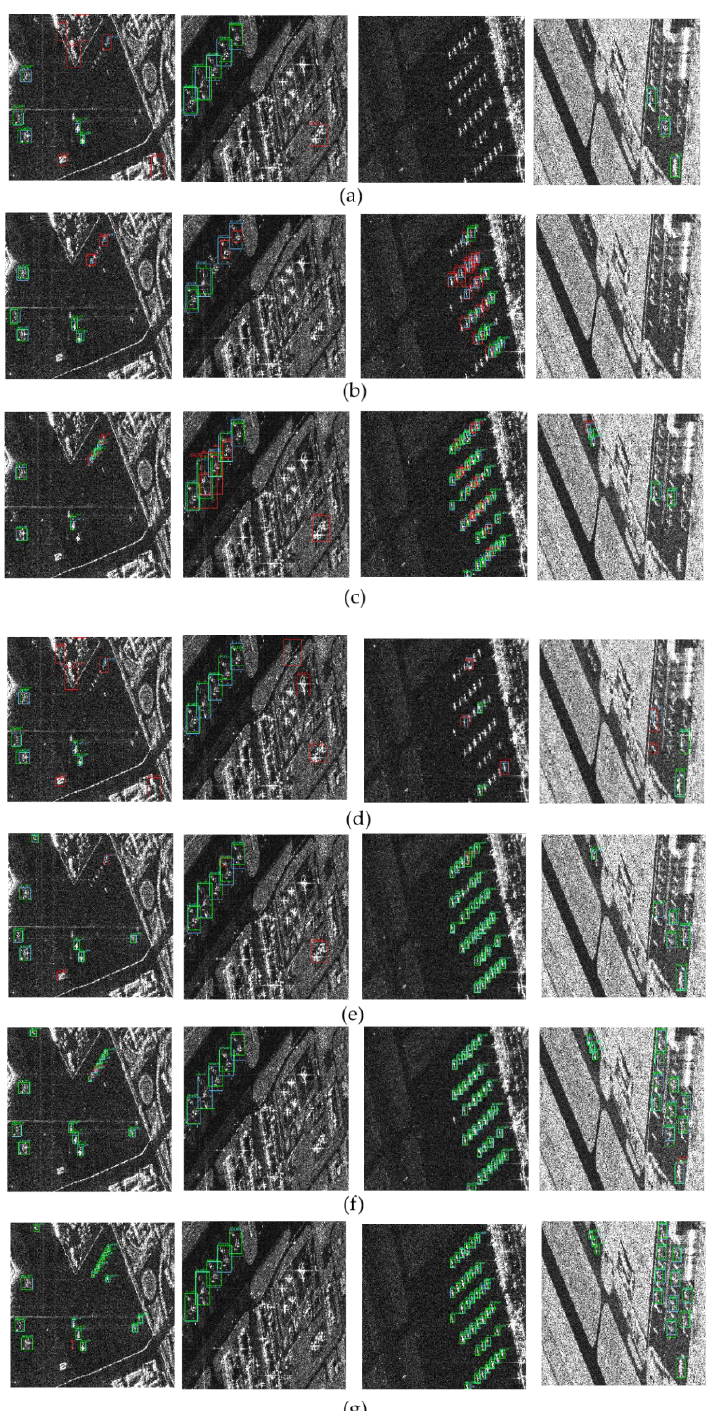
Figure 11. Detection results of each algorithm in four typical SAR scenes. Specifically, the scene in the first (from left to right) column contains mainly medium-sized and small-sized aircraft in a dense arrangement. The scene in the second column represents large-size aircraft against a complex background. The scene in the third column includes lots of small-size aircraft in dense arrangement situations. The scene in the fourth column includes both large and small aircraft and there is a lot of clutter noise in this environment. ( a ) RFB, ( b ) YoloV4-tiny, ( c )MobileNet-yolov4, ( d ) FasterRcnn, ( e ) RetinaNet, ( f ) ADN, ( g ) PFF-ADN.